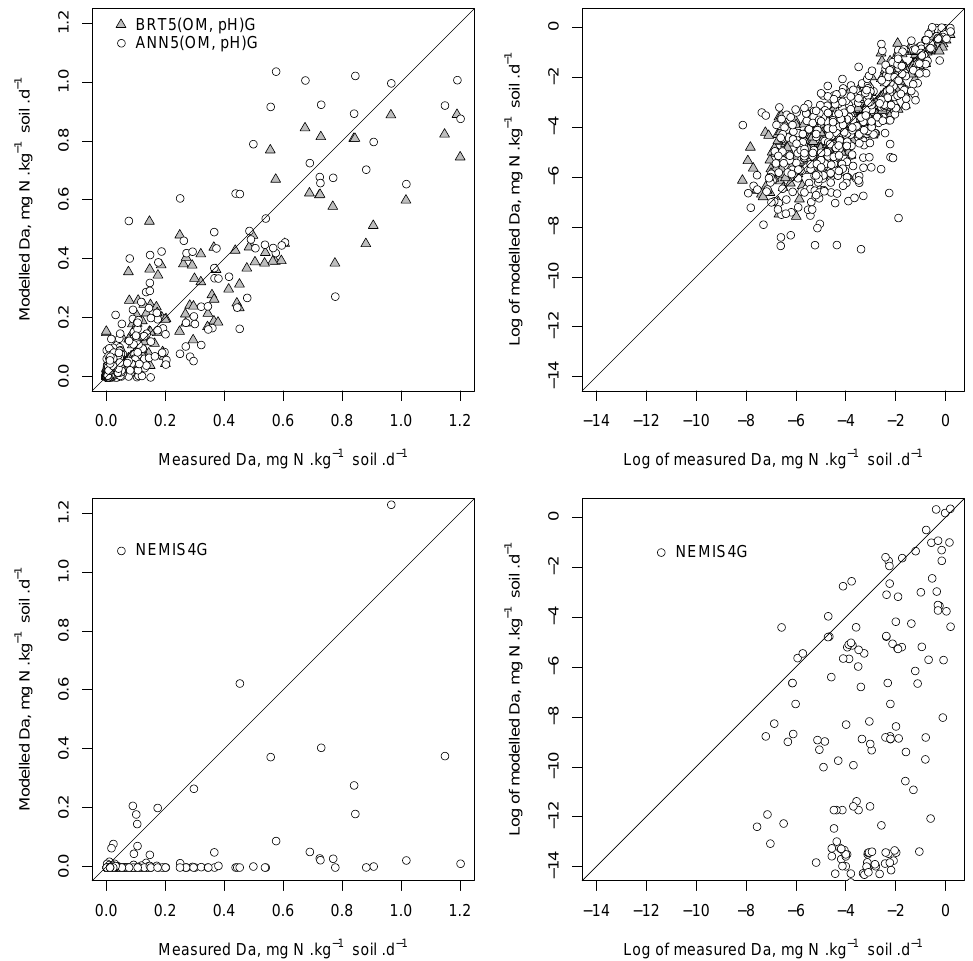
Fig. 7. Comparison of BRT5(OM, pH)G, ANN5(OM, pH)G and NEMIS4G (whole dataset without Henault and Germon (2000) and Ryden (1983) records) Da prediction performance (independent